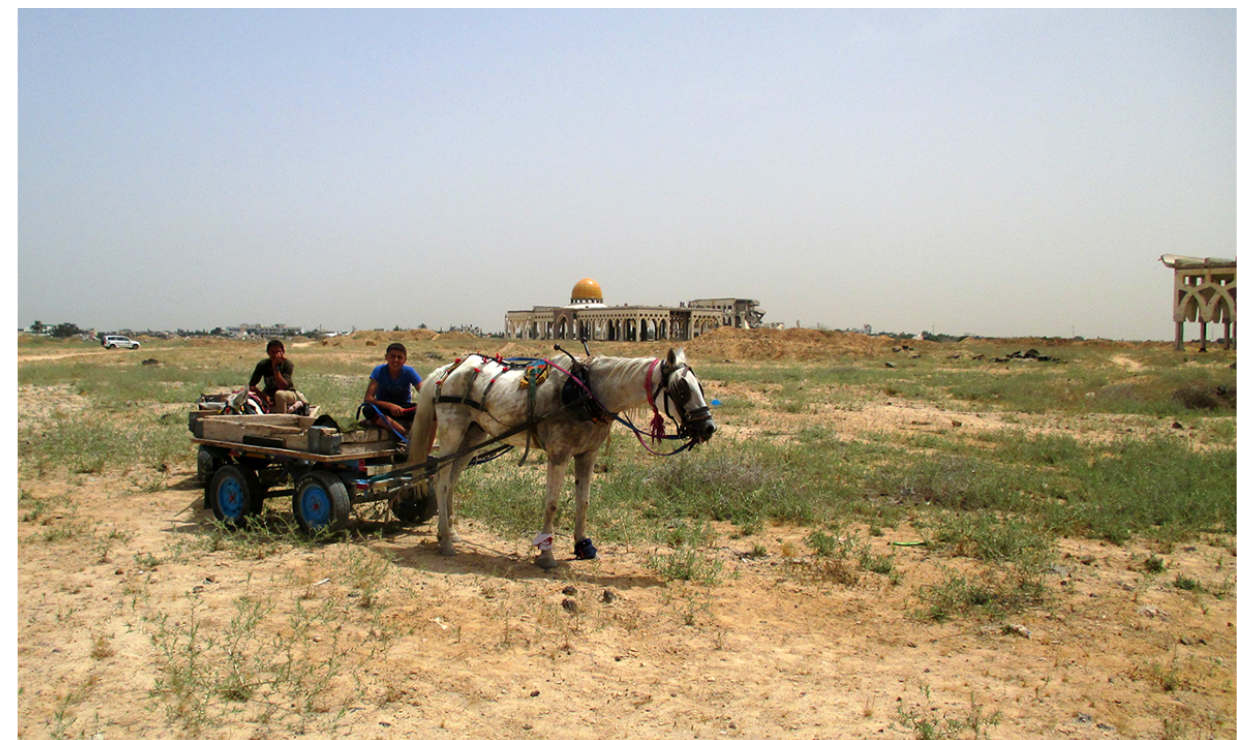
Figure 7. Destroyed Yasser Arafat International Airport at the southern border in the Gaza